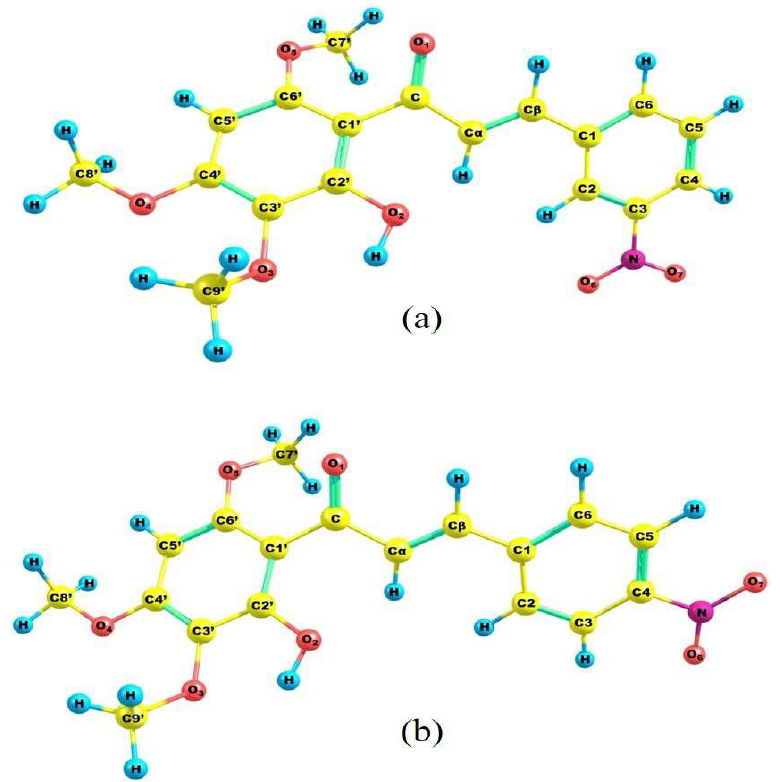
Figure 2. Molecular structure in the ball and stick model with the numbering of atoms for chalcone 1 ( a ) and 2 ( b ).